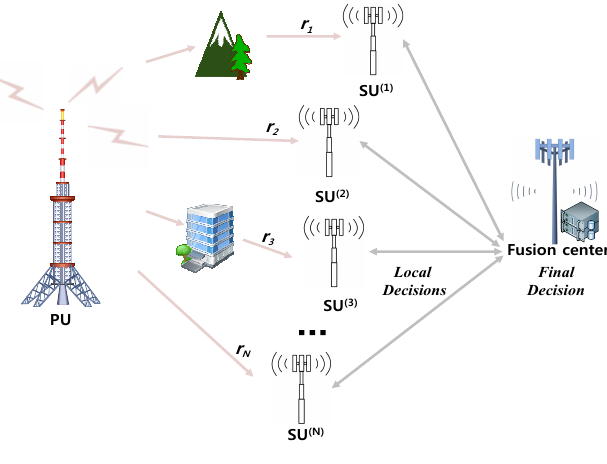
Figure 1. A scenario for cooperative sensing of cognitive radio system in wireless networks; there is a primary user, cooperative secondary users, and a fusion center. SU: secondary